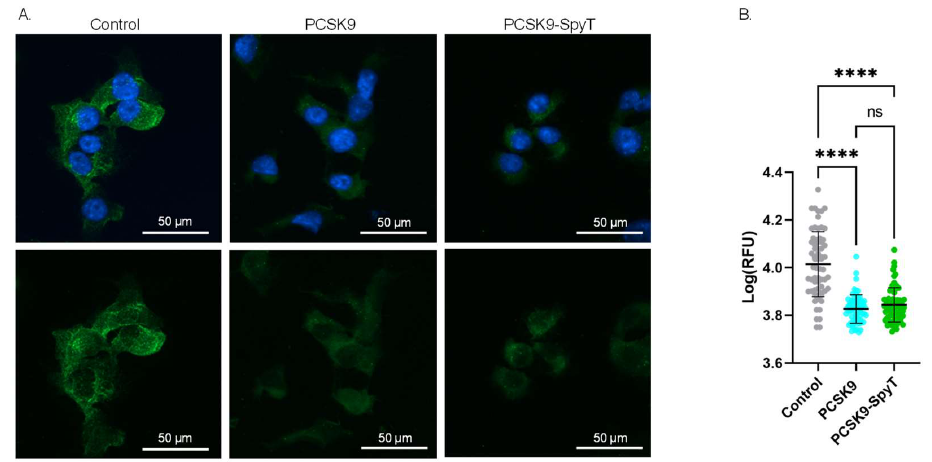
Figure 3. Biological activity of FL PCSK9-SpyT antigen by LDLR staining on Hepa1-6 cells. Hepa1-6 cells incubated with growth media (control), 100 nM FL muPCSK9 or 100 nM FL muPCSK9-SpyT for 4 h at 37 °C. Cells were stained with DAPI (blue) and anti-LDLR-FITC (green). ( A ). Representative cells are shown as merged pictures (top) or FITC signal alone (bottom). The size bar is 50 µm. ( B ). The relative fluorescence unit (RFU) was determined ( n = 65) by Cytation5 software and depicted as mean ± SD. Statistical analysis was performed on log-transformed RFU values using one-way ANOVA, Tukey’s multiple comparisons test (adjusted p -value < 0.05 was accepted as significant, ns > 0.05, **** < 0.0001).).